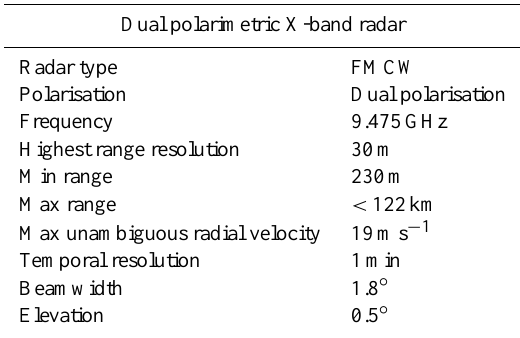
Table 2. Specification of the X-band radar of